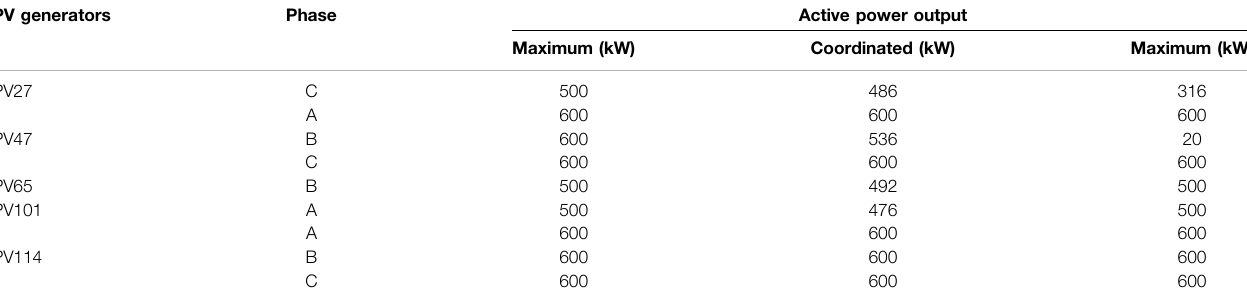
TABLE 4 | Active power output comparison among different strategies. PV generators